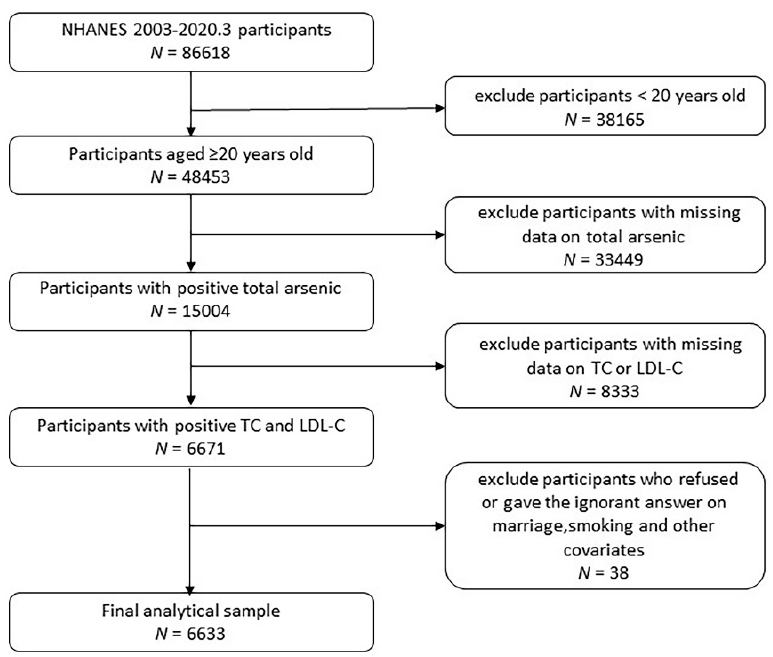
Figure 1. Flowchart of enrolled participants.